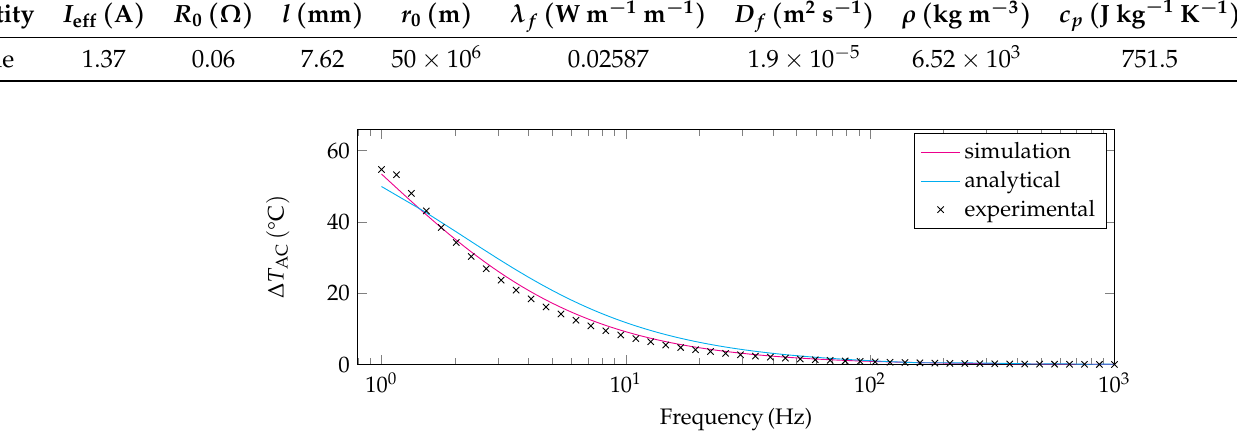
Figure 4. Comparison of experimental data to the simulation data and the analytical results in case of ambient air. of ambient